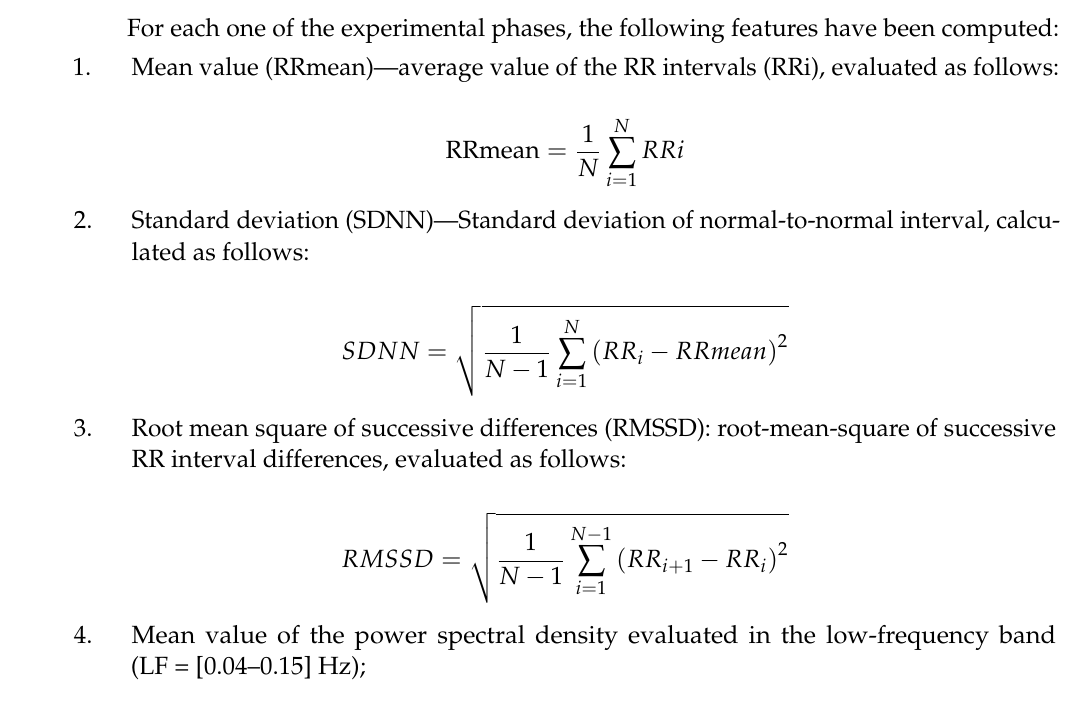
Figure A2. Exemplificative ECG signal. Example of R peaks and RR intervals are highlighted.